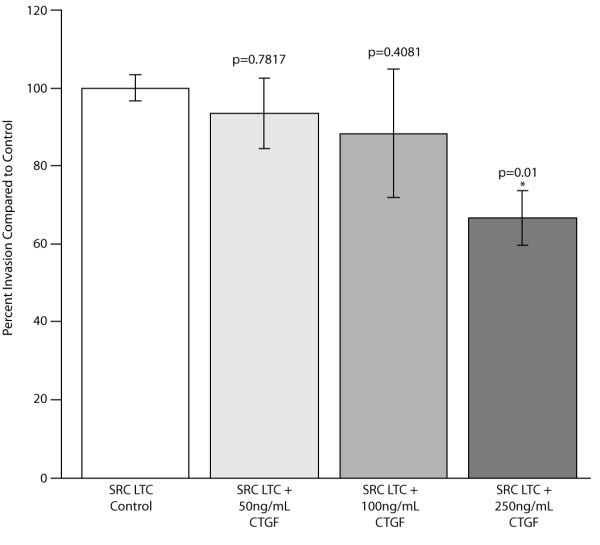
CTGF treatment decreases the invasiveness of SRC cells. Invasiveness was measured in control SRC cells (SRC Control) and in SRC cells treated with CTGF (50, 100, and 250 ng/mL) at the start of the invasion assay. Twenty-four hours later, the invasiveness was calculated for all samples and the results are displayed as experimental sample compared to the untreated control SRC cells (100% invasion). The bar represents the average invasion indices of biologic replicates, and the error bars represent the standard deviation of 3 biologic replicates.'*' Indicates values that are significantly different than the "SRC Control" sample (p < .05).